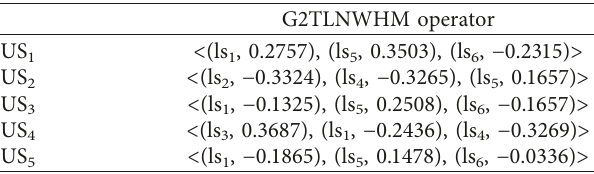
Table 2: The fused results by G2TLNWHM operator.